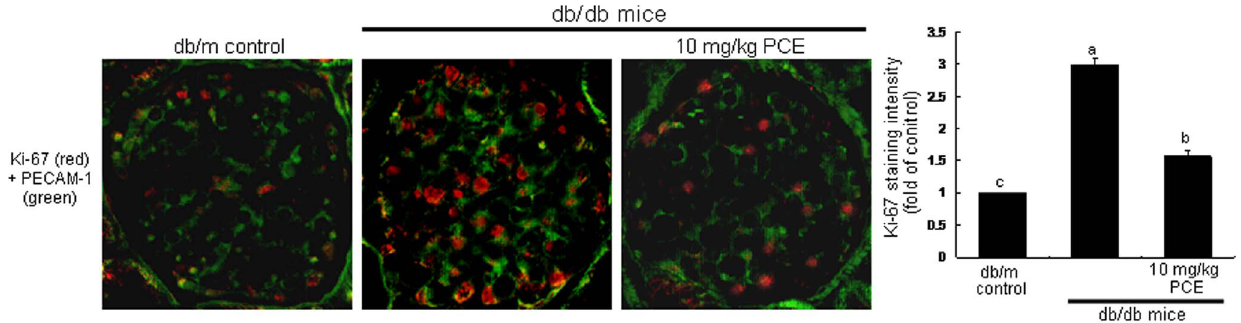
Figure 3. Double-immunofluorescence staining showing PECAM-1 (green) and Ki-67 (red) in db/db mice supplemented with PCE. The db/db mice were orally supplemented with 10 mg/kg PCE daily for 8 weeks. The db/m mice were employed as diabetic controls. For the measurements of the tissue level of Ki-67, histological sections of mouse kidneys were immunohistochemically stained by using anti-mouse Ki-67 and Cy3-conjugated IgG. The Ki-67 level was identified as reddish staining. The sections were also stained with anti-mouse PECAM-1 and FITC-conjugated IgG. Each merged image is representative of four animals. Magnification: x400. The bar graphs (mean 6 SEM, n=3) in the right panel represent quantitative staining intensity of fluorescent Ki-67. Respective values not sharing a letter are different at P , 0.05.